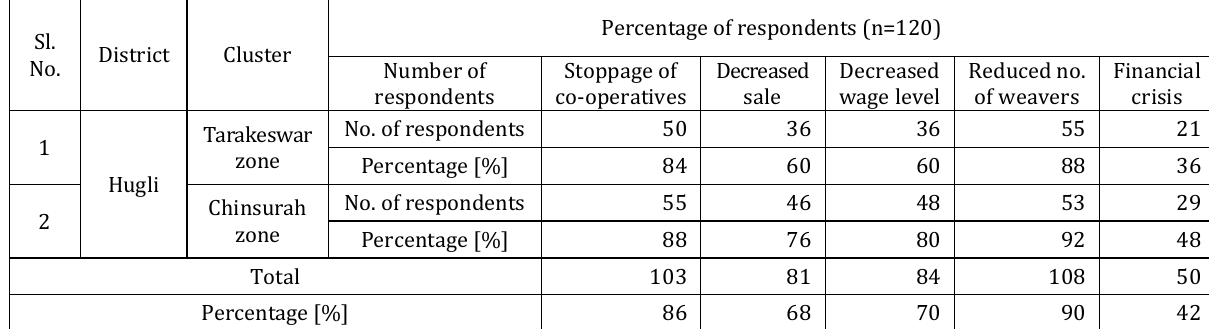
Table 5. Table showing result of declining performance of the PWCS (n=120) (Source: Primary survey 2017–2018)